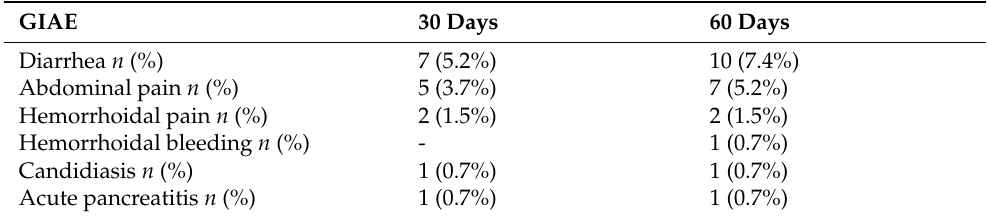
Table 2. Number and type of GIAE at 30 and 60